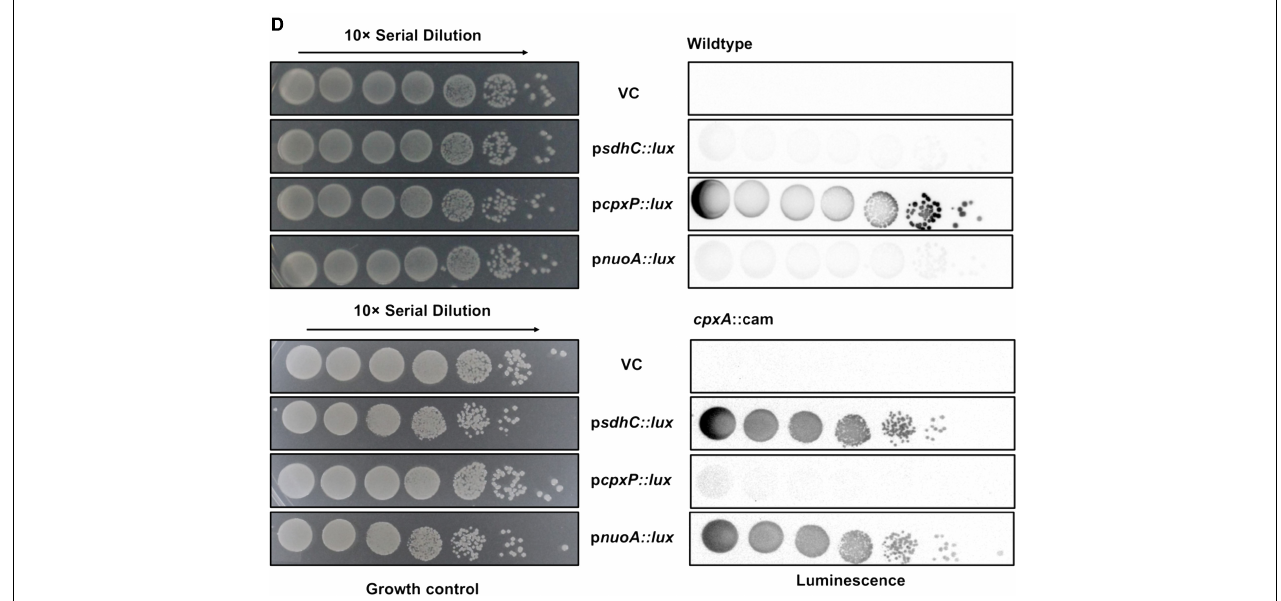
FIGURE 1 | Transcription of the sdh operon encoding the succinate dehydrogenase complex is downregulated by the Cpx stress response. Overnight cultures of wildtype Escherichia coli MC4100 or a cpxA ::cam mutant harboring either pJW15 (vector control) or the (A) p cpxP :: lux , (B) p nuoA :: lux , or (C) p sdhC :: lux reporter plasmids were subcultured 1:100 into fresh LB medium and incubated at 37 ◦ C with shaking. The luminescence and the OD 600 were measured every hour for the duration of 7 h and a final measurement was taken at 24 h. Data correspond to the mean values from three biological replicates. Error bars depict standard deviations (SDs). (D) Luminescence activities are shown for wildtype E . coli MC4100 or a cpxA ::cam mutant harboring either pJW15 (vector control) or the p nuoA :: lux , p sdhC :: lux , or p cpxP :: lux reporter plasmids. Luminescence was determined by imaging the luminescence of the strains after 24 h of growth on LB